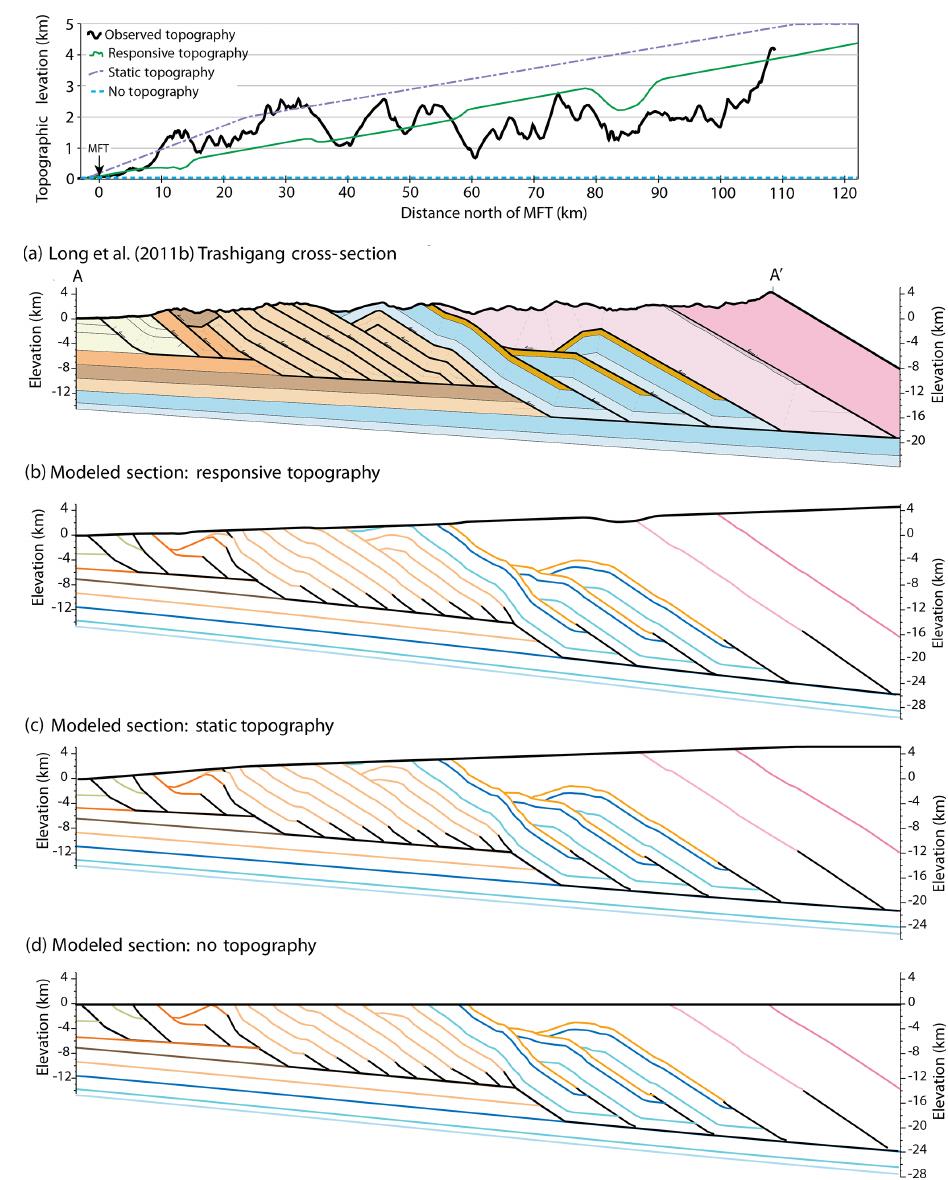
Figure 4. Vertically exaggerated topographic model elevations compared to observed topography of the Trashigang section. (a) Long et al. (2011b) Trashigang cross section. The flexural–kinematic models shown were created using Split KT and (b) responsive, (c) static, and (d) no